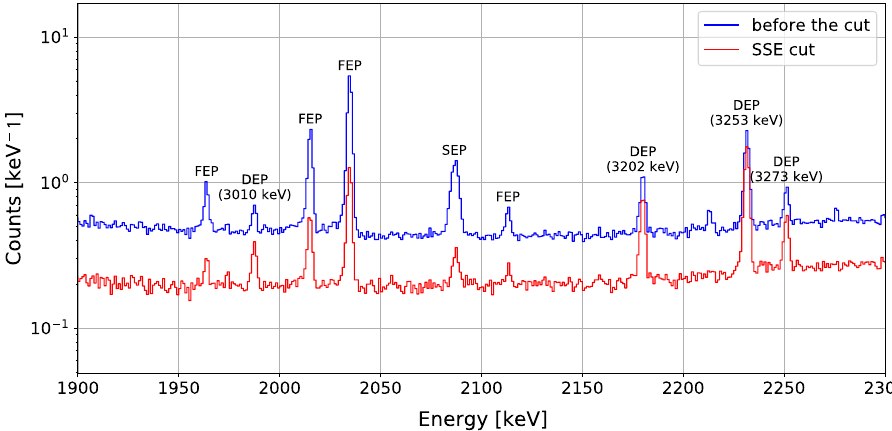
increased single- and multi-events densities are clearly visible – a simi- larstructurelikeforthe 228 Th data.ThecutatANN=0.52formtraining performed on 228 Th was applied